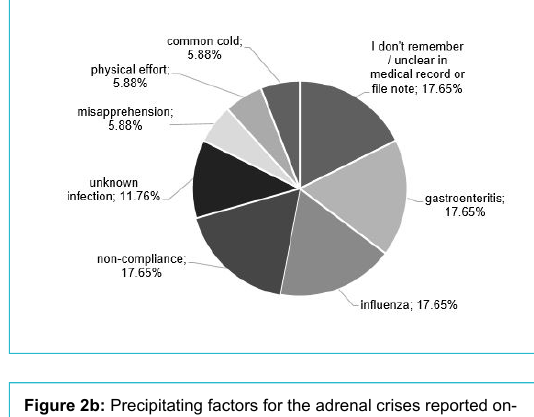
Figure 2a: Precipitating factors for the adrenal crises reported by the patients and confirmed by medical records or file note.